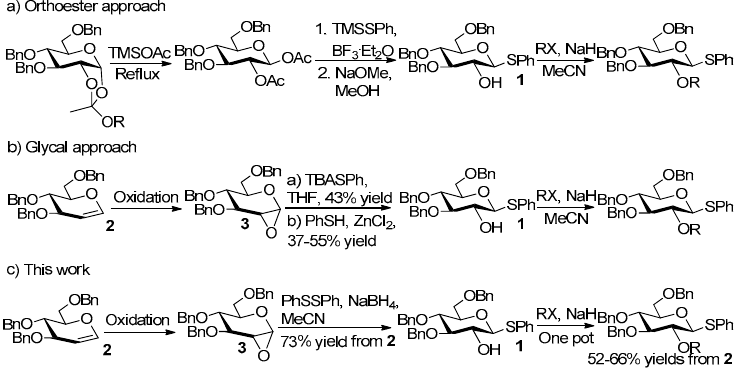
Figure 2. Comparison of this method with previous methods.